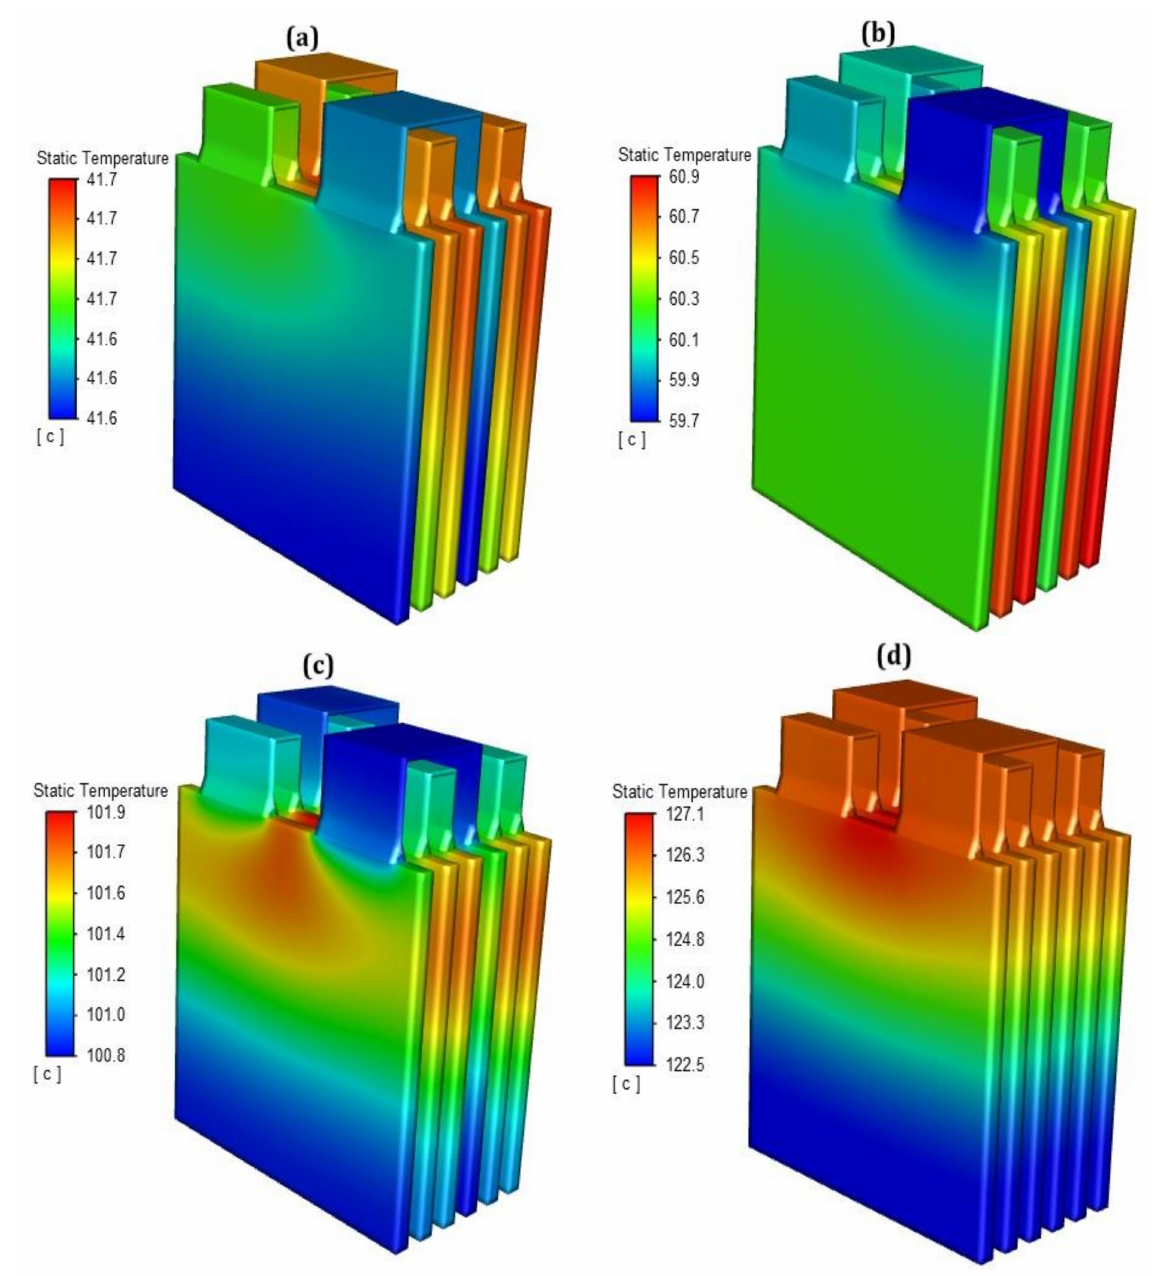
Figure 5. LIB module temperature distribution without cooling at discharge rate of ( a ) 0.5C, ( b ) 1C, ( c ) 3C, and ( d )